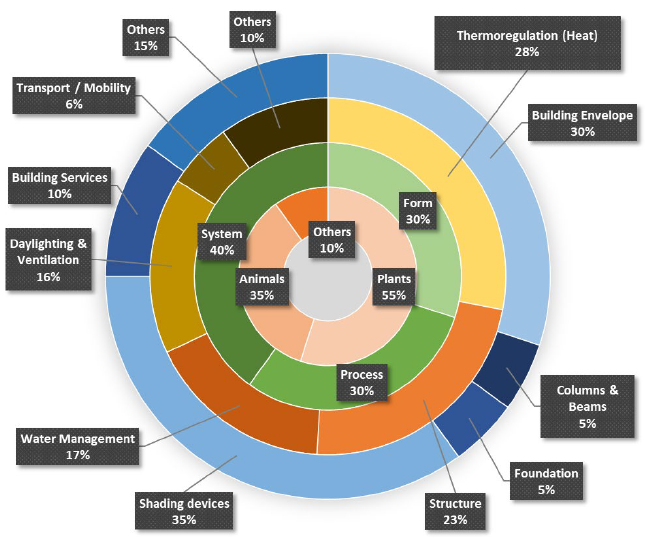
Figure 13. Classification of student projects by the type of model organism, type of biomimicry, themes, and biomimicry application at different